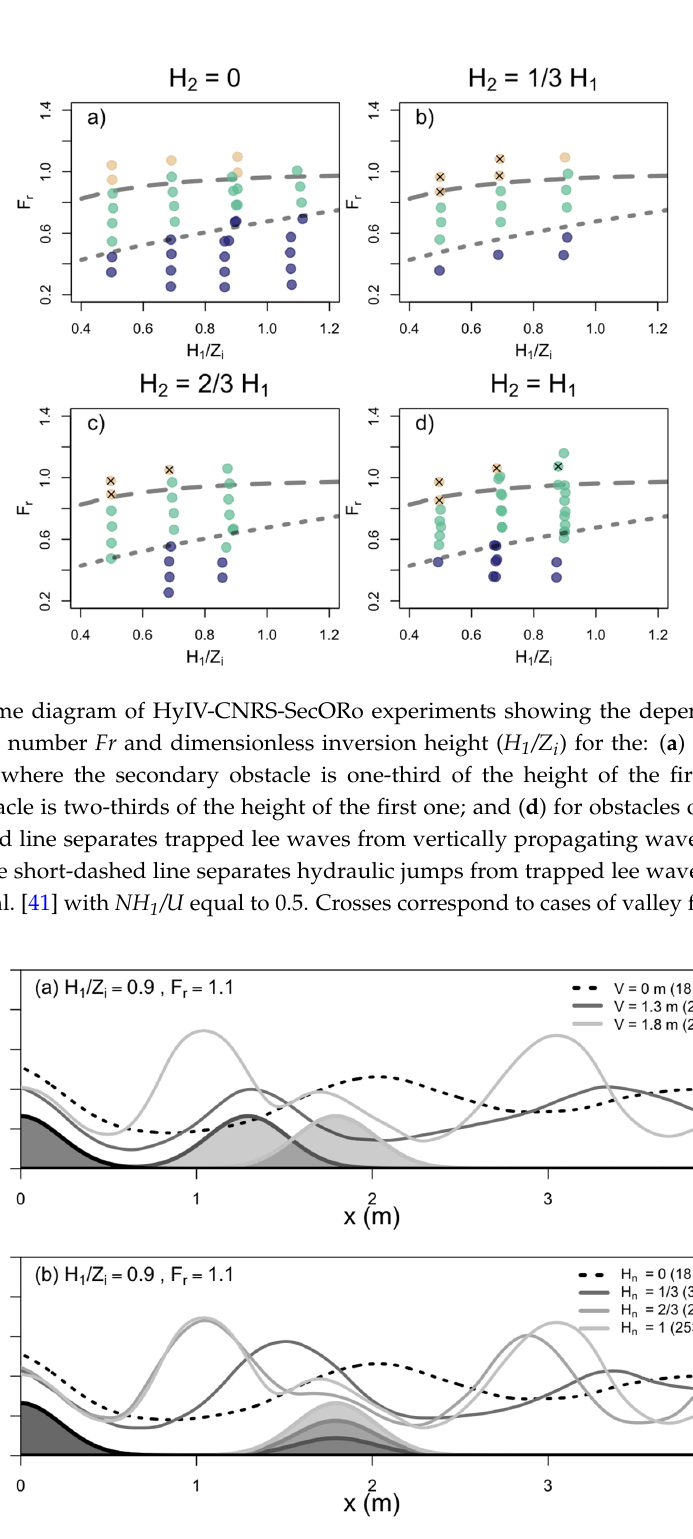
Figure 7. Interface displacement for a set of double obstacle runs with fixed H 1 /Z i = 0.9 and median F r equal to 1.095, for ( a ) different valley widths; ( b ) different heights of the second obstacle.